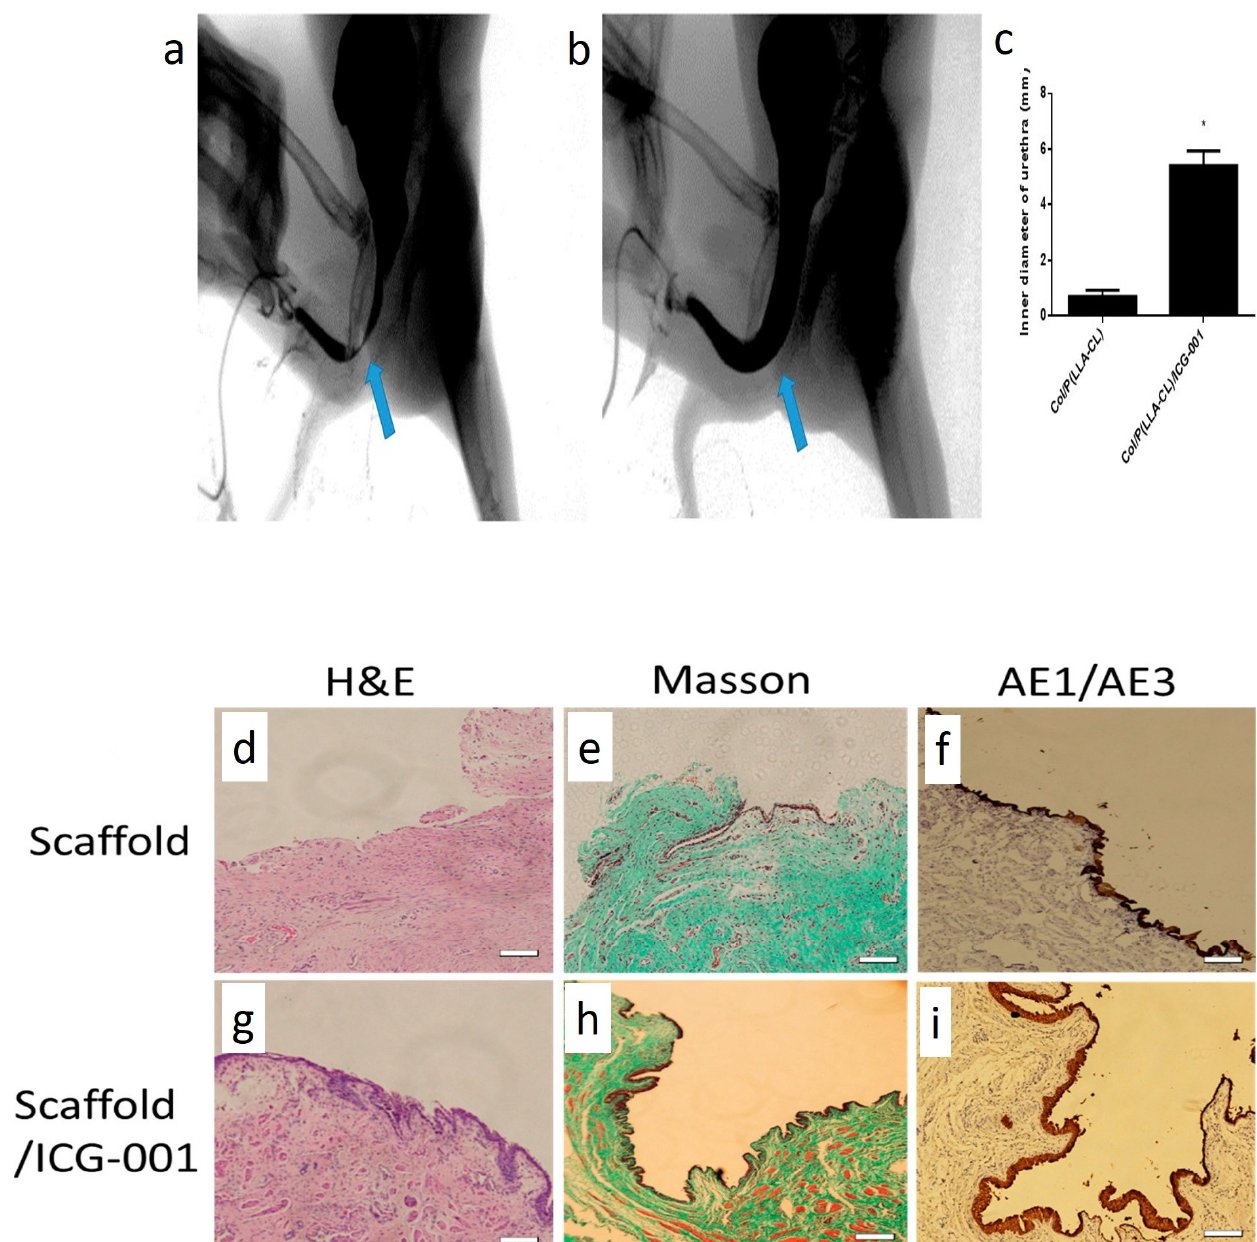
Figure 11 . ( a – c ) show the urethrography images of animals treated with collagen/PLLA-CL and collagen/PLLA-CL/ICG-001 scaffolds, respectively. The blue arrow indicates the surgery position. ( d – i ) shows the histopathological examinations of urethra tissues in different groups. * shows p -value < 0.05. Adopted from reference [232]. Scale bars: 100 μ m.